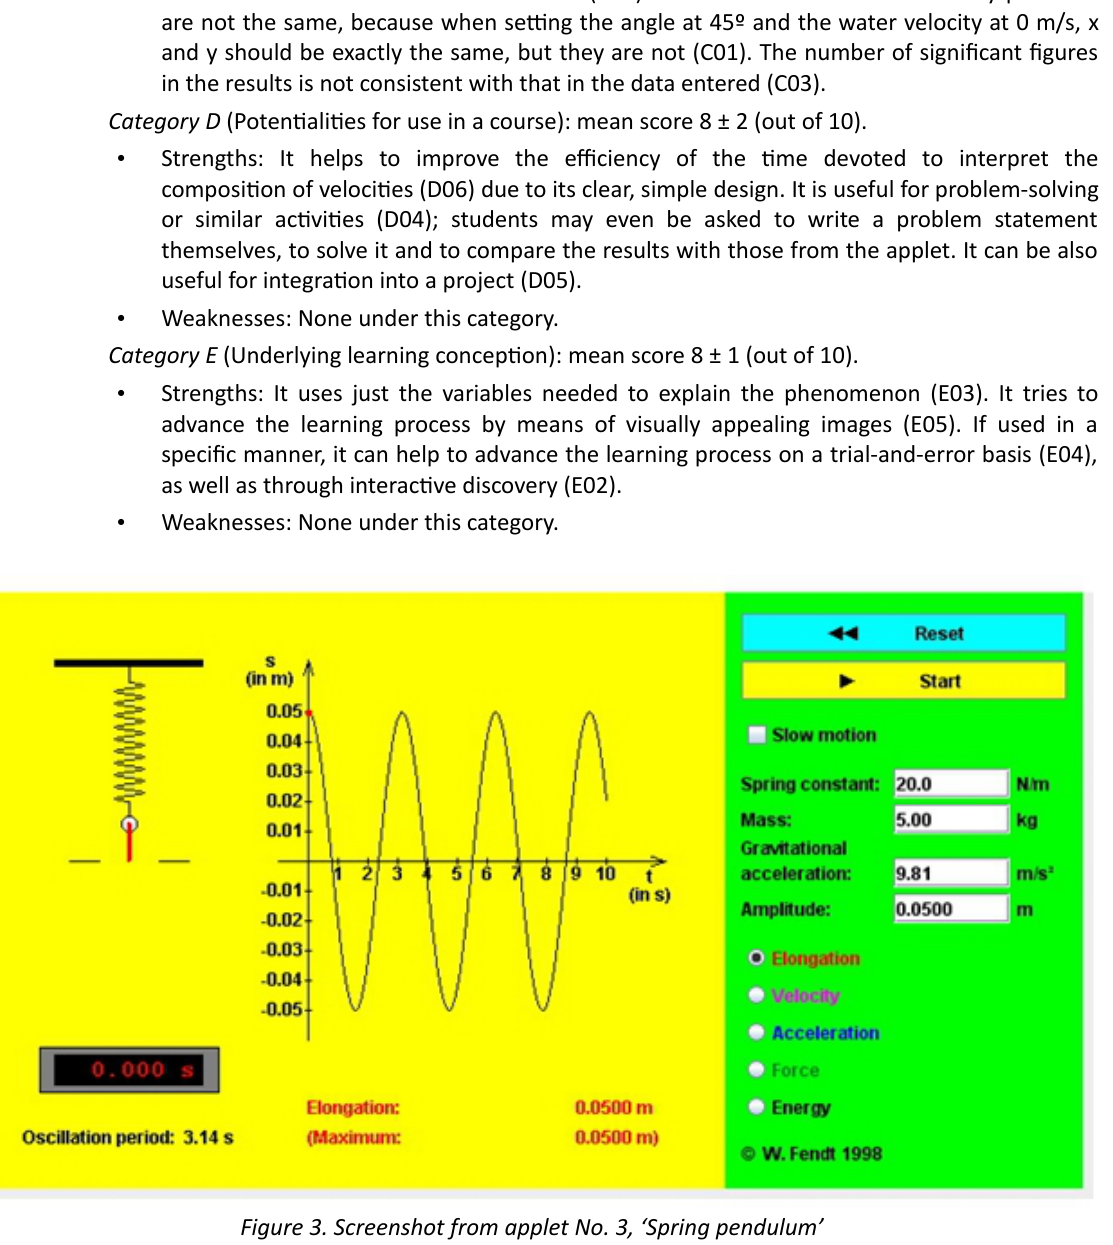
Description: (Figure 3) The applet simulates the simple harmonic motion of a mass and spring system (assuming no friction), displaying elongation, velocity, acceleration, force or energy vs. time.